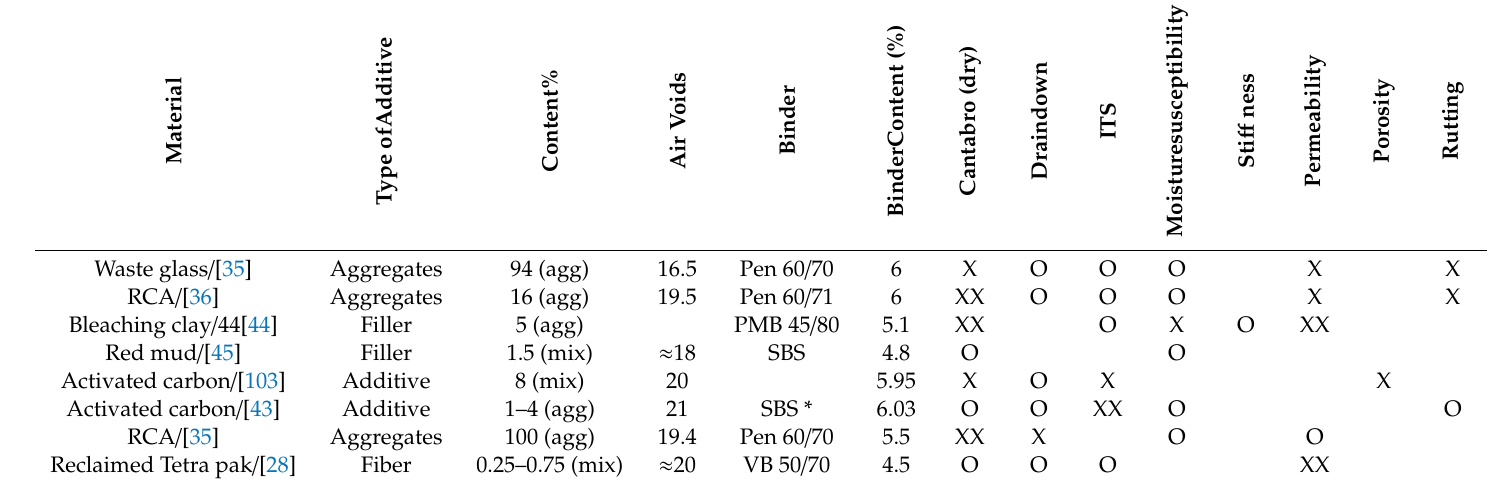
Table 4. Comparison of eco-friendly materials with virgin materials. RCA—recycled concrete